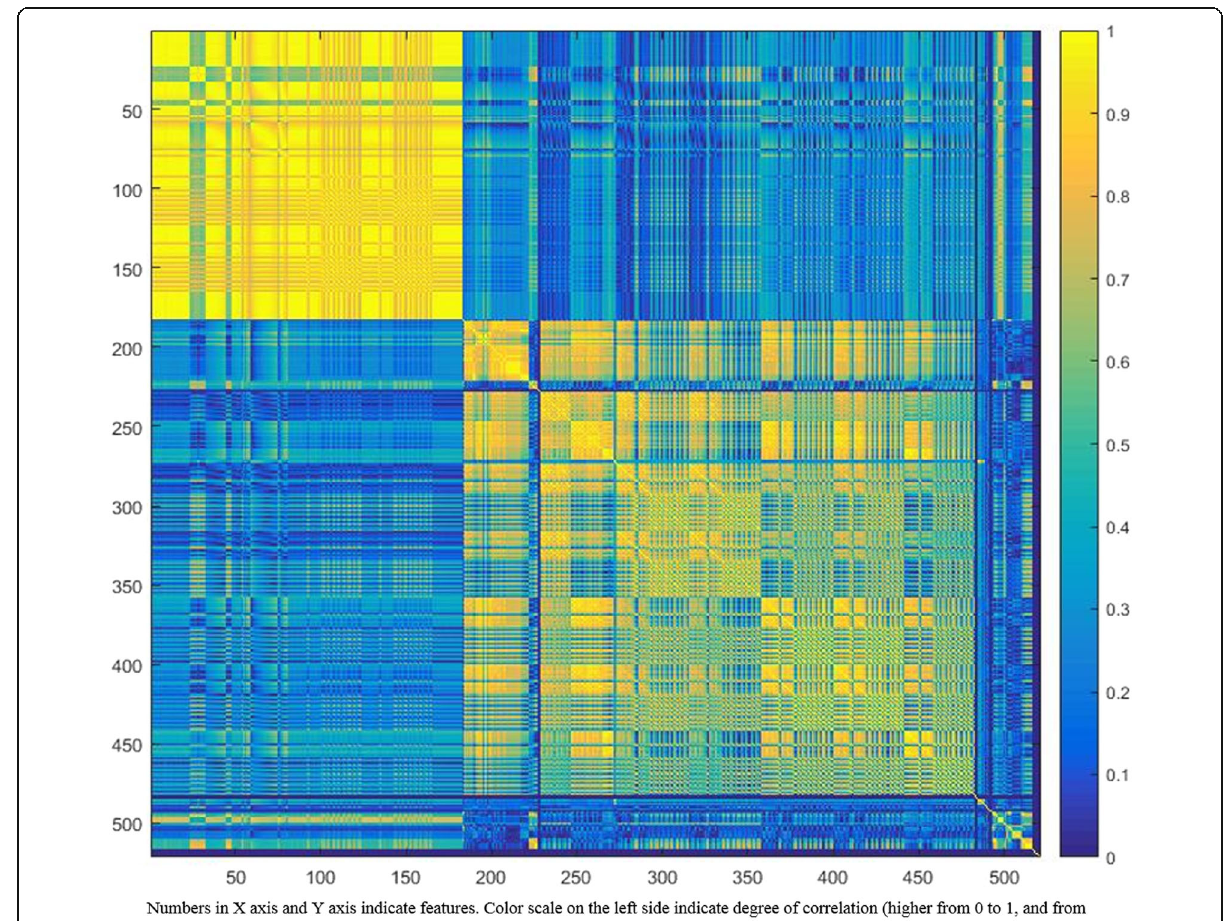
Fig. 1 Graphic representation of radiomic-feature clustering. This example graph displays the absolute value of the correlation coefficient (ranging from 0 to 1, on the right side, indicating increasing degree of correlation) between each pair of radiomic features (shown as numbers on the two axes). The heat map gives a good visual representation of the high correlation observed for most radiomic features that may be grouped in the same cluster to avoid redundancy. The yellow blocks along the diagonal graphically identify the clusters including highly correlated radiomic features. Blue blocks outside the diagonal visualise the low correlation observed between radiomic features belonging to different clusters. In the present example, two major clusters with different information may be identified, with very high redundancy for radiomic features in the first cluster (high homogeneity of the yellow